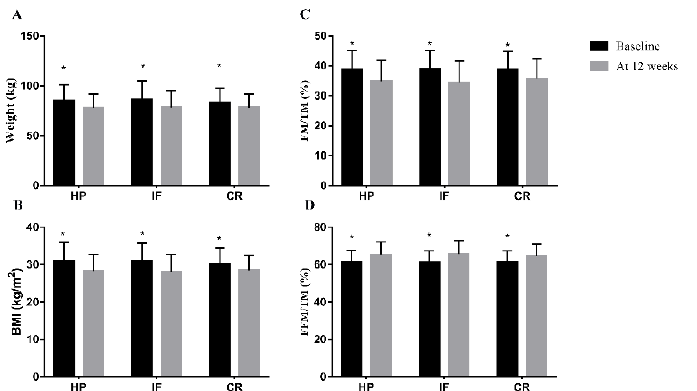
Figure 3. The differences within groups. ( A ) Weight; ( B ) BMI; ( C ) FM/PM; ( D ) FFM/TM. BMI, Body